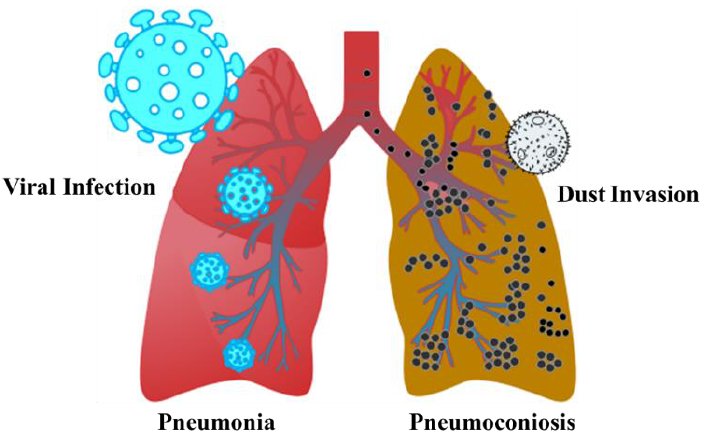
Figure 1. Diagram of pneumoconiosis and pneumonia.